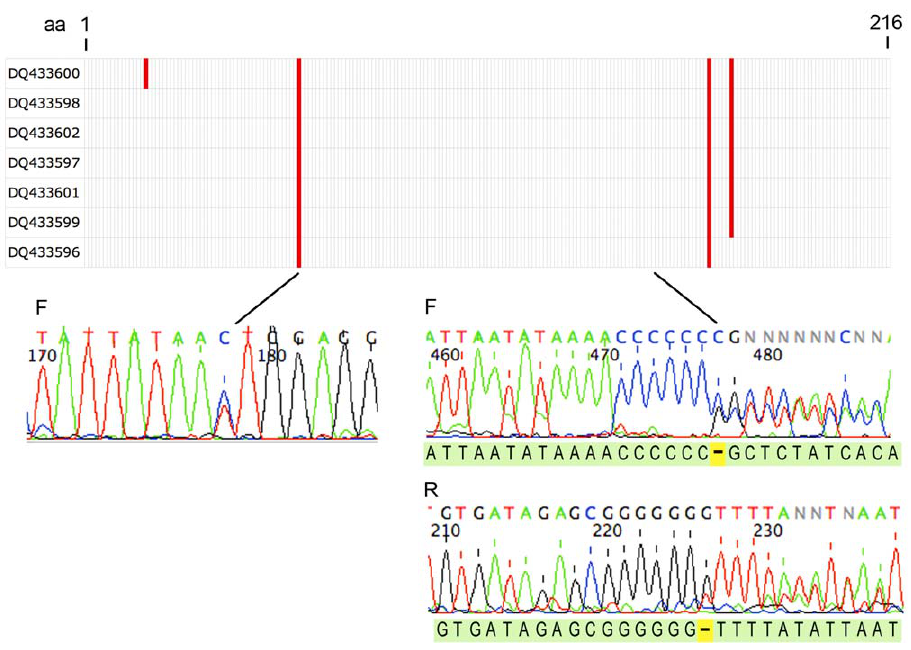
Figure 4. Empidonaxalnorum BARCODEs represent a co-amplified pseudogene. Schematic shows positions of amino acid VLFs in barcode segment for E. alnorum BARCODEs with GenBank accession numbers as indicated. Representative trace files shown below display a double peak underlying the 5 9 amino acid VLF and an overlooked single base insertion near nucleotide position 470. The GenBANK fasta file sequence corresponding to the insertion site is shown below the traces with the unrecorded nucleotide in